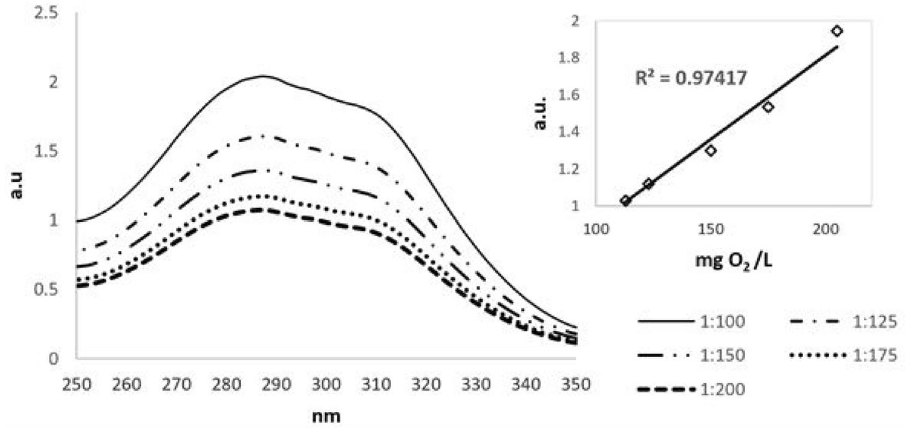
Figure 2. UV–VIS spectra of BL at different dilution ratio. The inset displays the correlation between COD and the absorbance at the corresponding